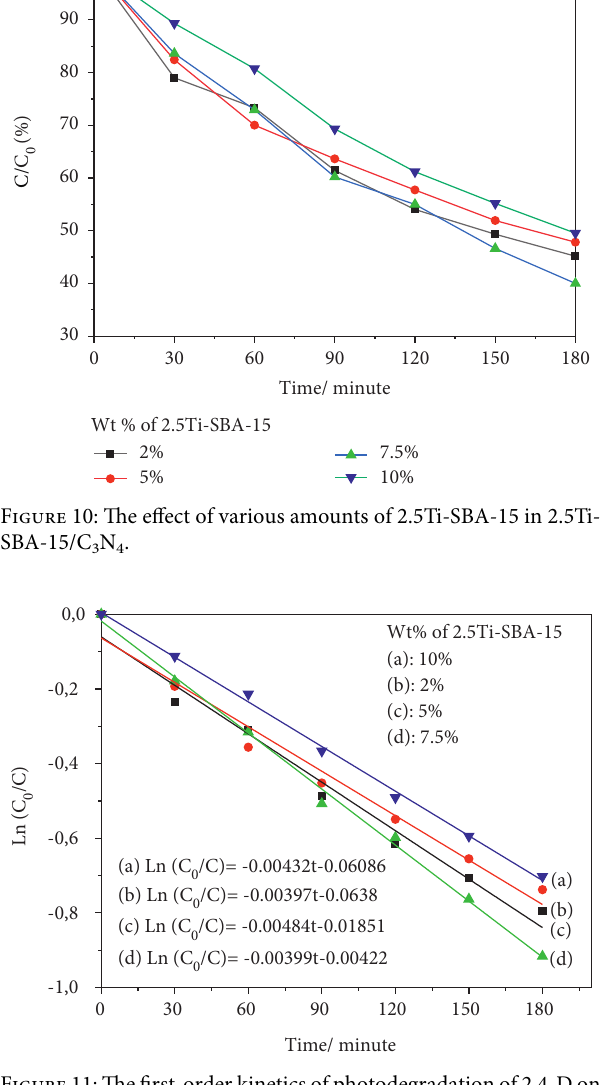
Figure 11: The first-order kinetics of photodegradation of 2,4-D on the catalyst.